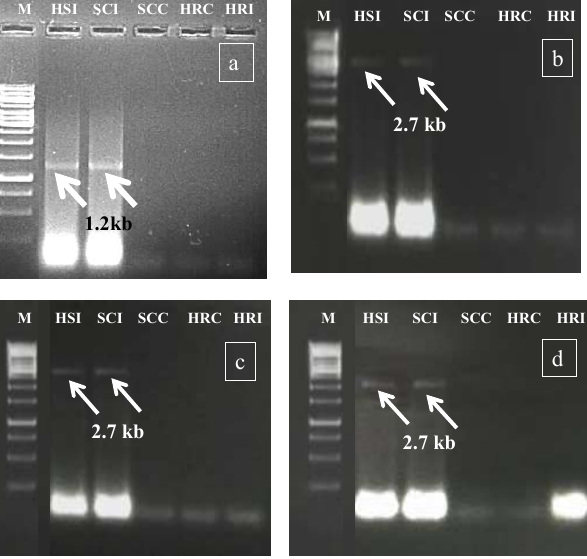
Figure 2. ( a ) Preliminary confirmation of Geminivirus infection by Rojas primer during rabi 2017. ( b ) Confirmation of HgYMV infection by HgYMV DNA A primer during rabi 2017. ( c ) Confirmation of HgYMV infection by HgYMV DNA A primer during kharif 2018. ( d ) Confirmation of HgYMV infection by HgYMV DNA A primer during rabi 2018. M—1 kb marker; HSI—highly susceptible infected; SCI—susceptible check infected; SCC—susceptible check control; HRC—highly resistant control; HRI—highly resistant infected.